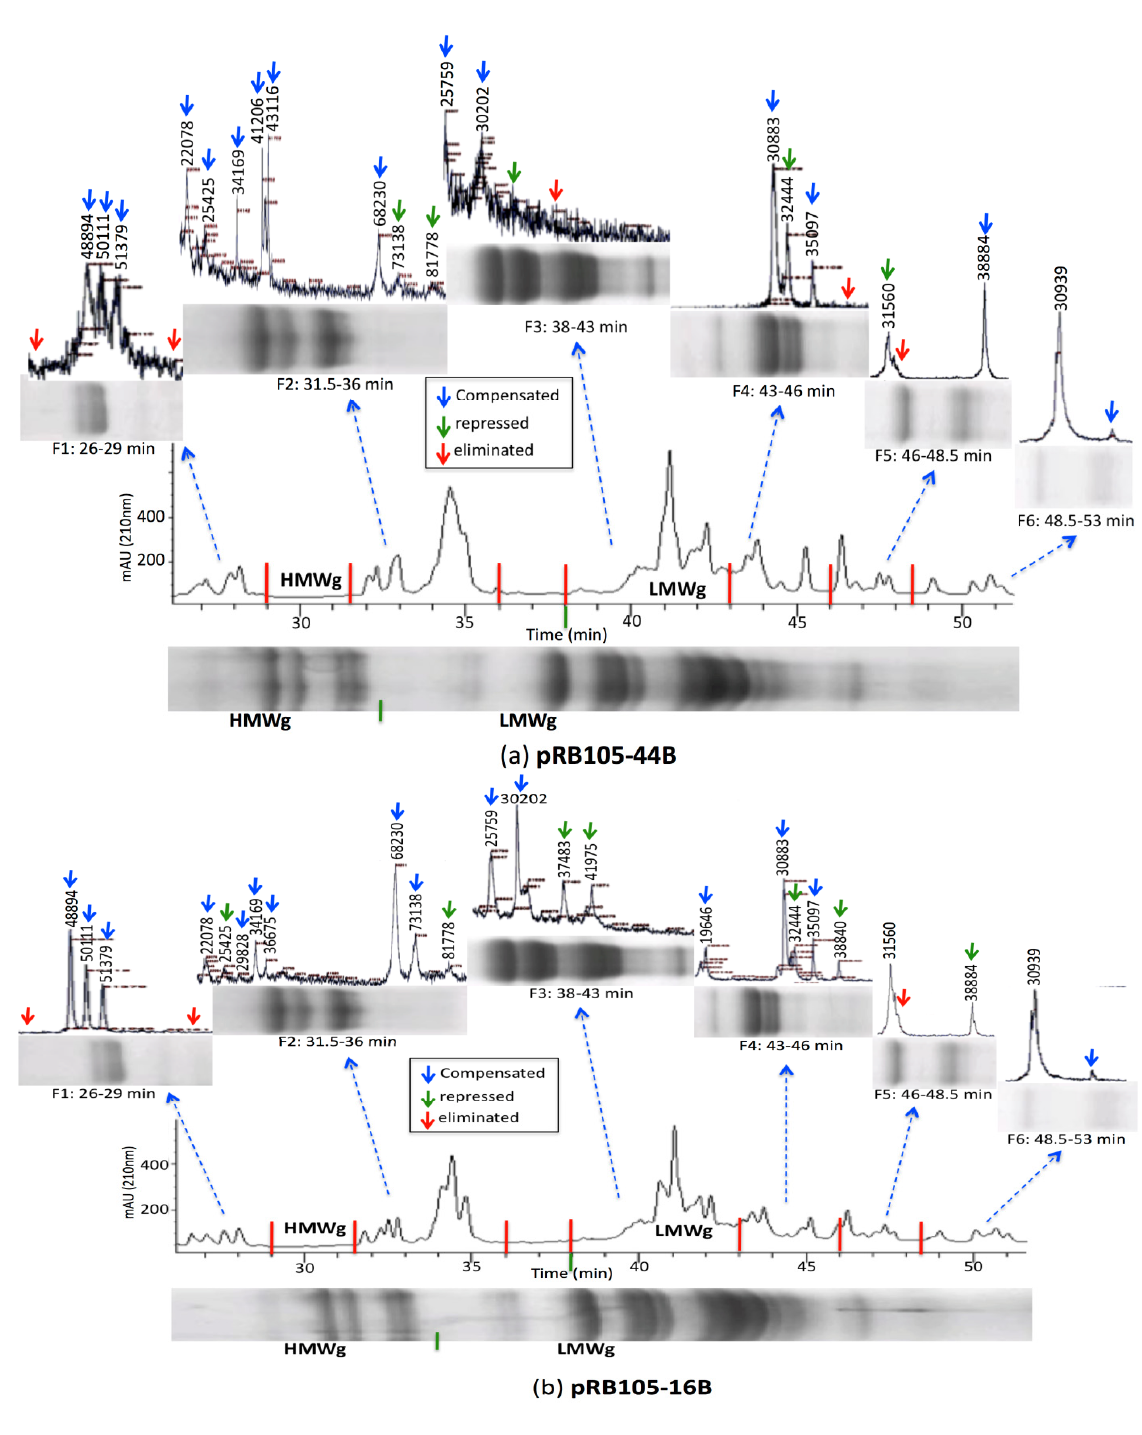
Figure 4. Mass spectra and electrophoresis patterns of glutenin extracts from two wheat transformants, namely pRB105-44B ( a ) and pRB105-16B ( b ). Six HPLC fractions were collected at 26–29, 31.5–36, 38–43, 43–46, 46.0–48.5 and 48.5–53.0 min, and resolved on SDS-PAGE gels as well as by MALDI-TOF-MS. Red arrows indicate complete elimination, green arrows indicate reduced accumulation, and blue arrows indicate a compensatory increase in amount of a protein compared to the wild type control Brundage 96 ( cf . Figure 2); F =